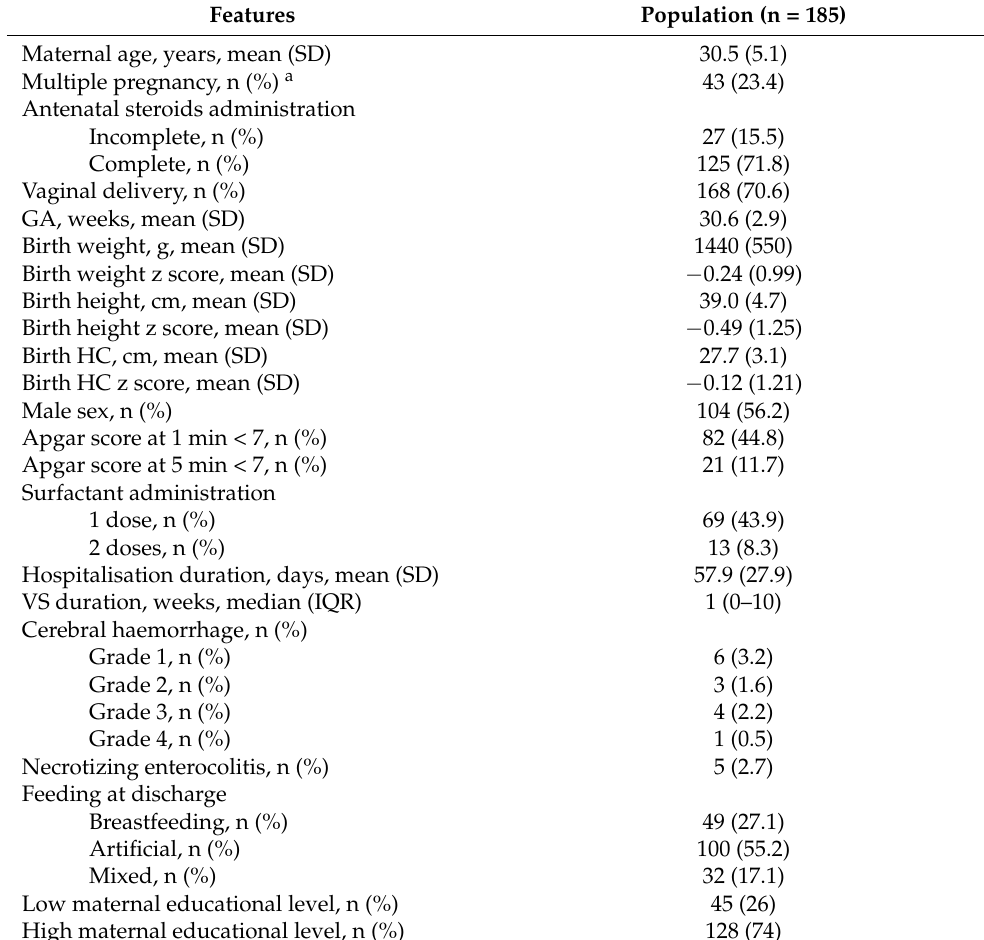
Table 1. Features of included